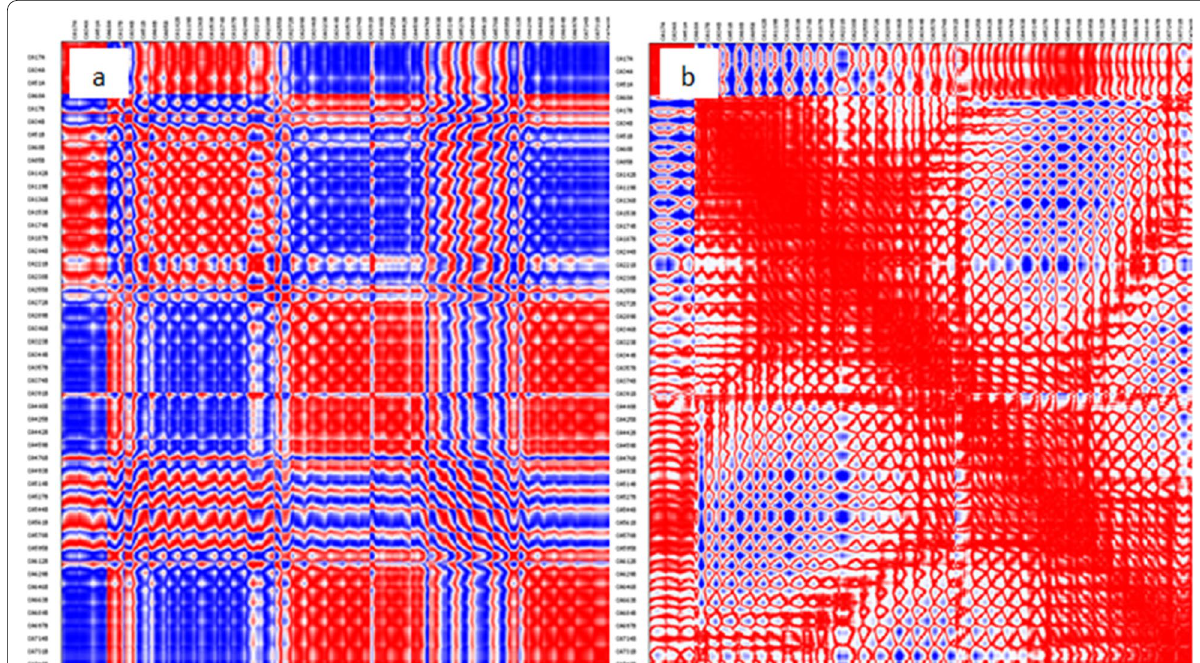
Fig. 9 Molecular dynamics of docked complex. a Correlation maps. b Covariancce map